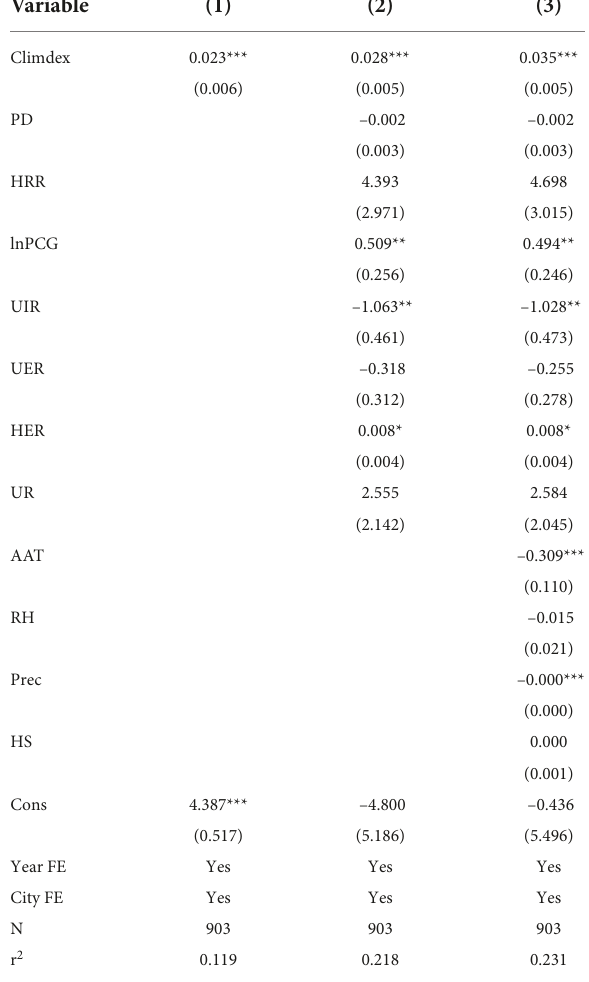
TABLE 2 Baseline regression results of climate extremes on crime